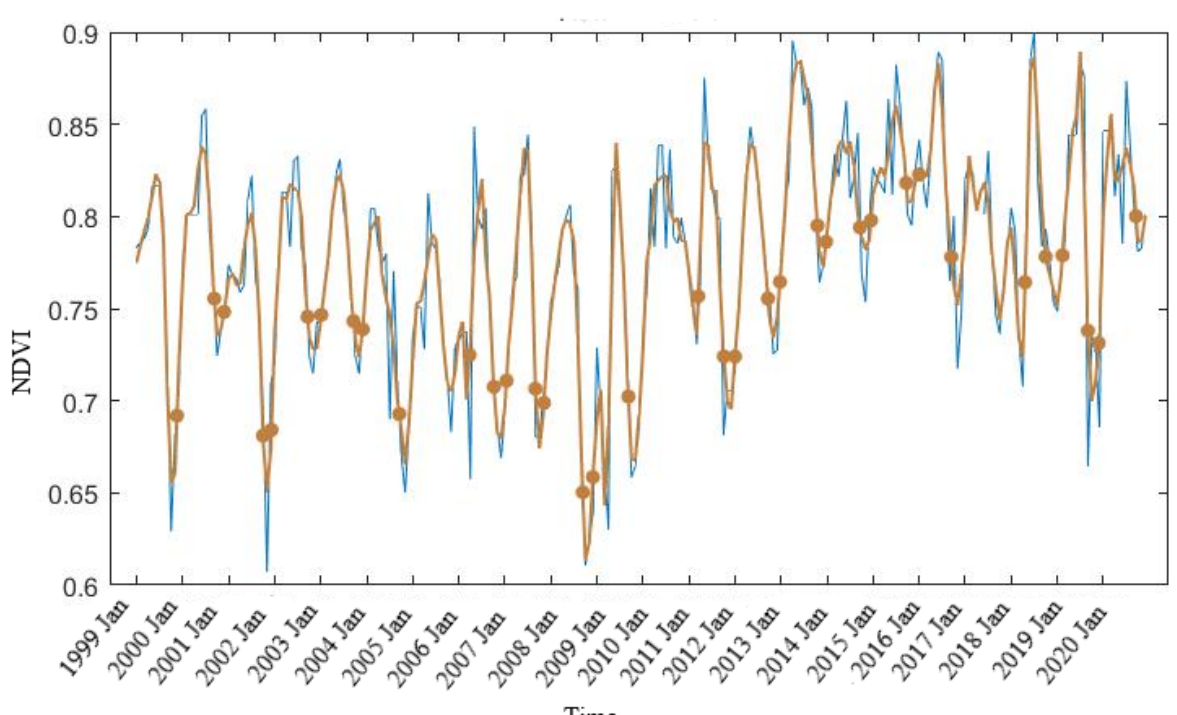
Figure 6. Mangrove forest intra-annual smoothing phenology with the Savitzky-Golay filter in TIMESAT using Landsat NDVI dense time-series data 1999–2020, blue line indicates the decadal NDVI data, brown line indicates the smoothed time series fitted data, brown dots display the start and end of the growing season for mangrove forest in the mid-section of our study region, Figure 1, Bowen to Shoalwater and Corio Bays Area Ramsar Wetland, Central Queensland.